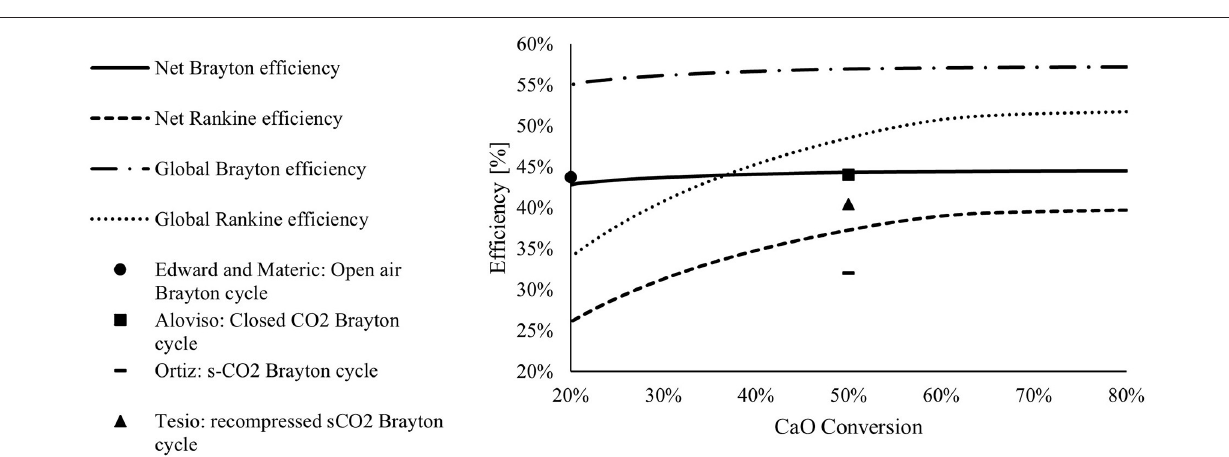
Frontiers in Sustainability |